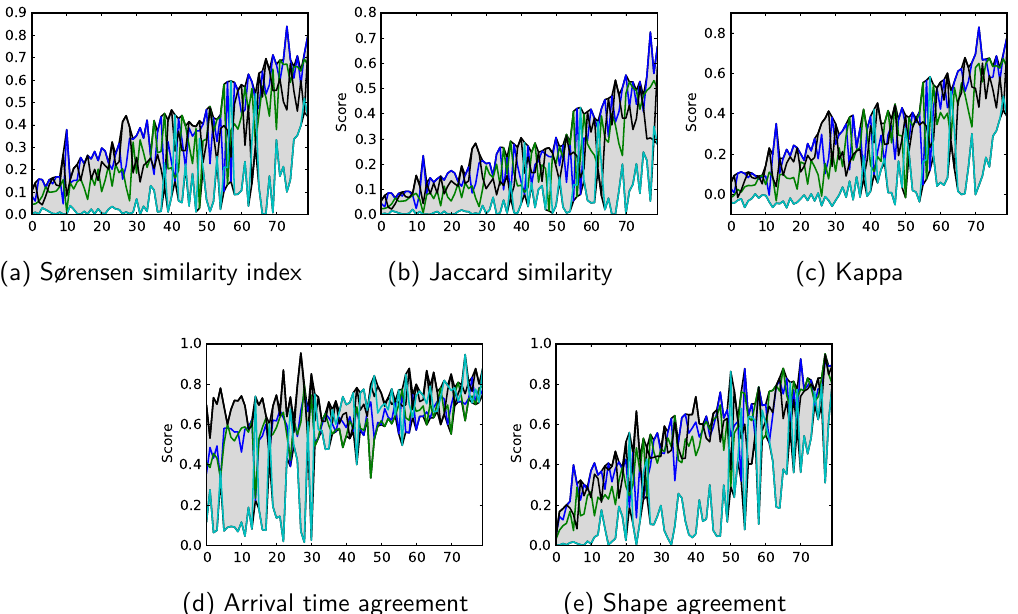
Figure 2. The distribution of the scores for the 80 cases and for the four models. The sorting was carried out with respect to the mean score 19 across the models. Hence, at a given abscissa, one can read the four scores for a given fire case. The grey area is delimited by the upper and lower bounds of the